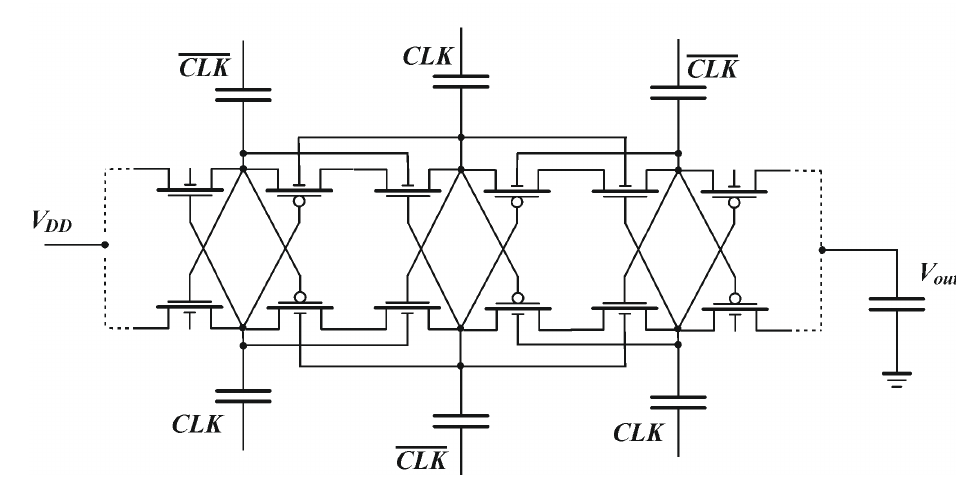
Figure 5. The switched capacitor converter presented in